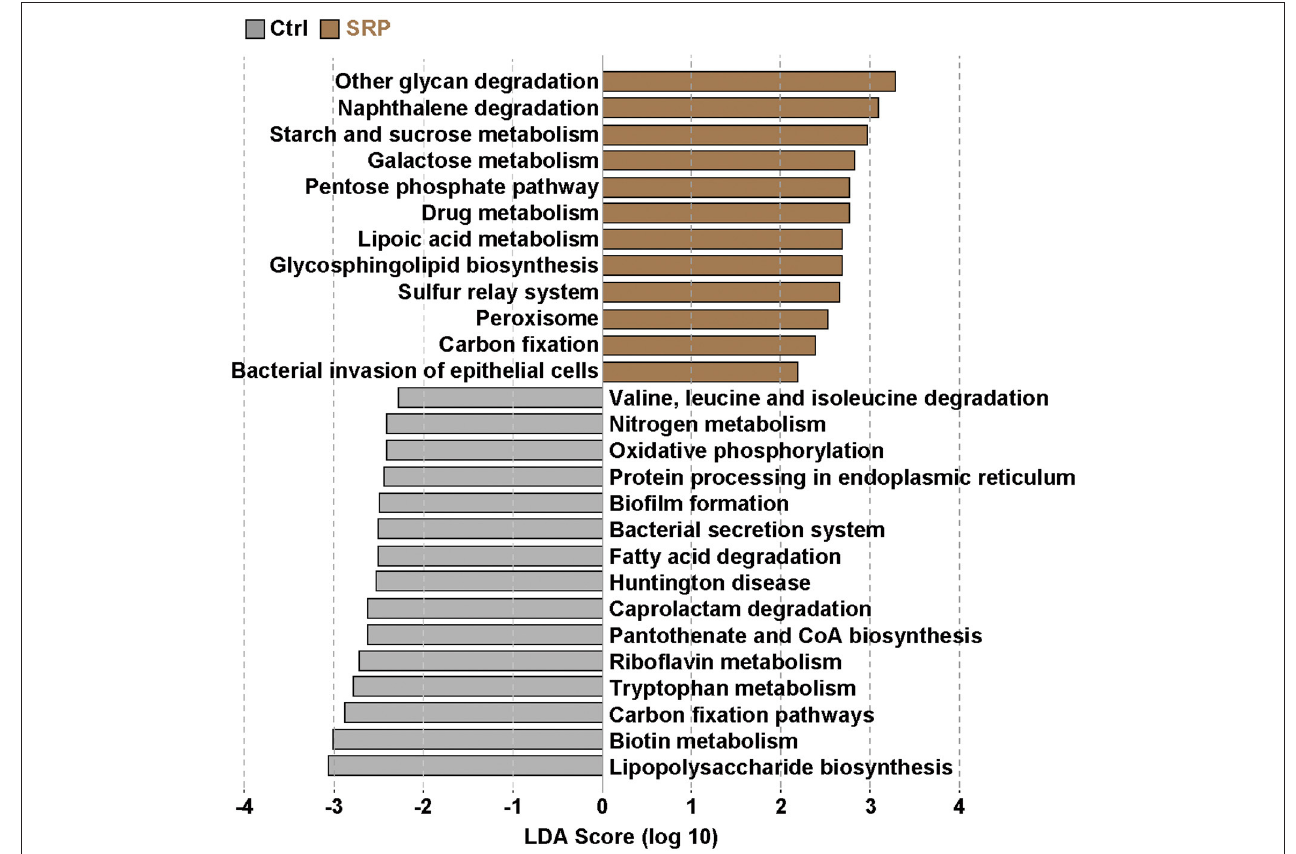
FIGURE 5 | Prediction of functional gene pathways of the cecal microbiota. The changes in the functional gene pathways in the cecal microbiota due to the SRP-diet were predicted using PICRUSt analysis. Brown bars represent the up-regulated pathways in the SRP group. In contrast, gray bars indicate the down-regulated pathways in the SRP group. Pathways were determined to be significantly different according to the LDA score (LDA > 2). Pathways showing significant differences ( p < 0.05) between the two groups were extracted by the Kruskal-Wallis and Wilcoxon rank-sum tests. Ctrl, control diet group; SRP, soybean resistant protein diet